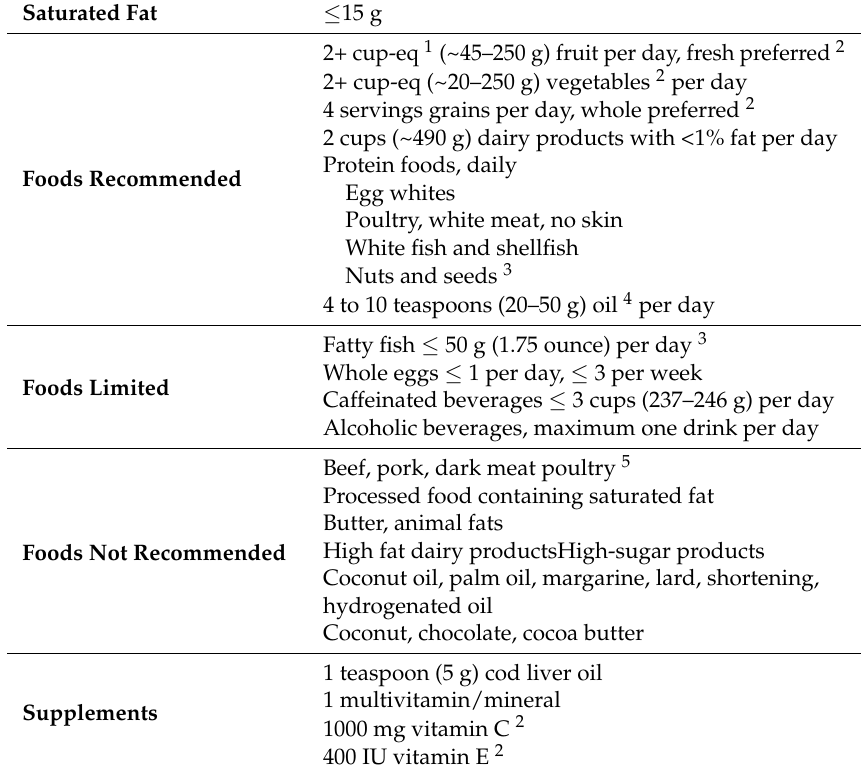
Table 1. Low saturated fat Swank [36,37] diet